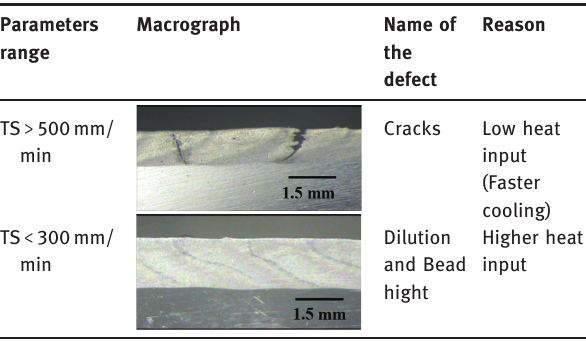
Table 4: Macrostructure analysis for fixing the working range of travel speed.